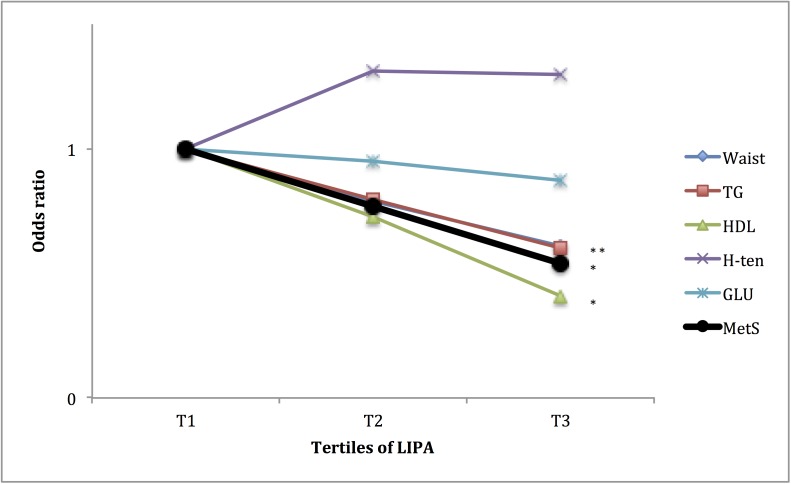
Relationship between tertiles of LIPA and unfavourable sub-components of METs.ORs are adjusted for gender, age, education level (university degree vs. not), energy intake (kcal·d-1 in quartiles), smoking habits (regular smoker vs. not) and psycho-social stress (self-reported into four levels), % of wear time spent in MVPA (in tertiles), and estimated VO2max (ml·min-1·kg-1, in tertiles). * Denotes significant difference to reference group.